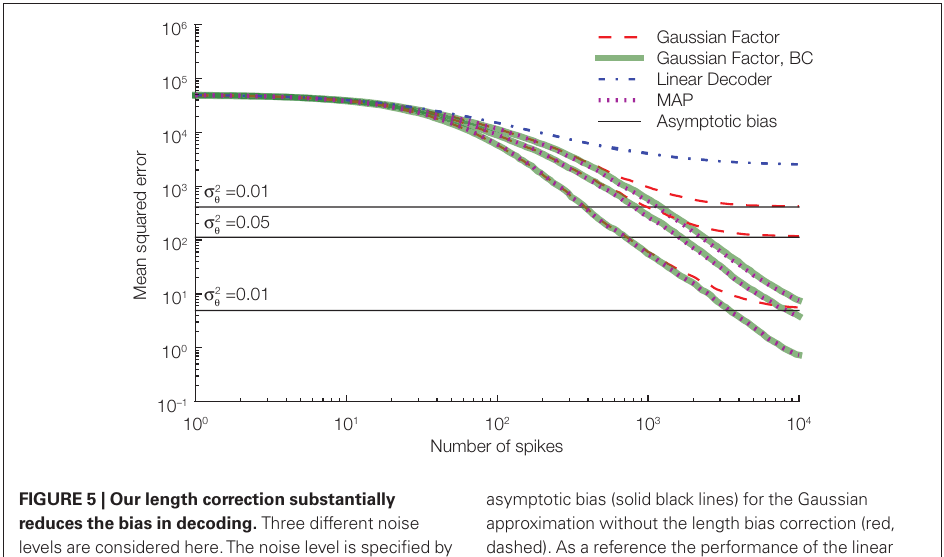
Figure 5 | Our length correction substantially reduces the bias in decoding. Three different noise levels are considered here. The noise level is specified by the variance of the thresholds drawn at spike times. The larger the noise level the more prominent is the